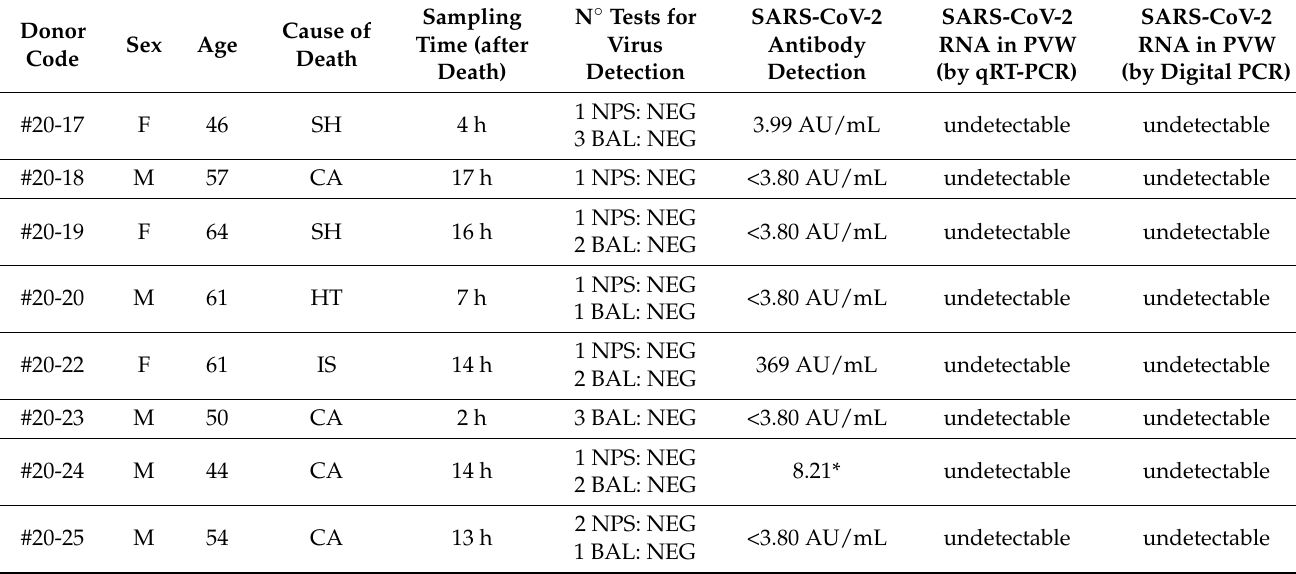
Table 1. Deceased donor details and results of SARS-CoV-2 antibody and RNA detection from serological tests and molecular